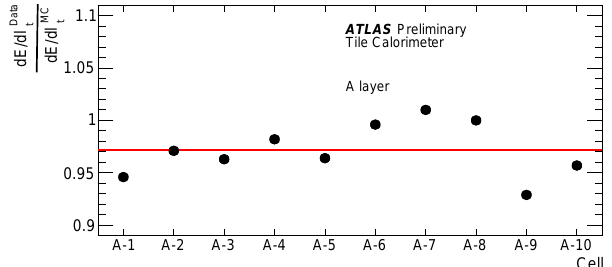
Figure 6: Ratios of the truncated means of the distributions of the energy deposited in the A layer cells per unit of path length obtained using a − 90 ◦ orientation with respect to the beam line; experimental and simulated muon data as a function of the cell number [ 5 ]